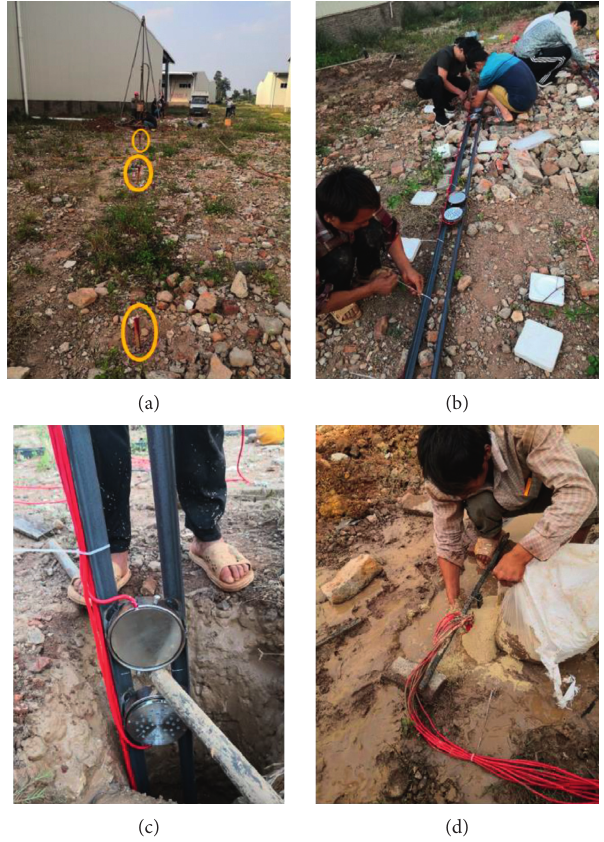
Figure 8: Diagram of monitoring elements erection and